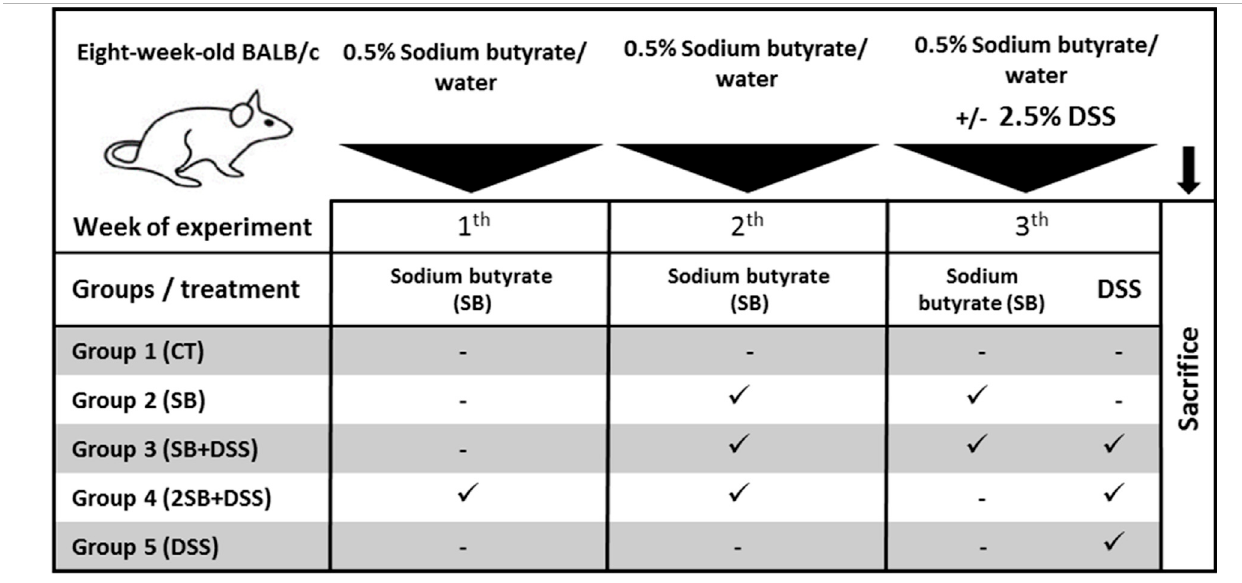
TABLE 1 | Experimental